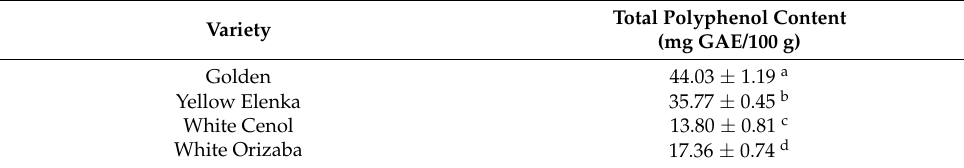
Table 1. Total polyphenol content (TPC) in four different A. cepa variety extracts.